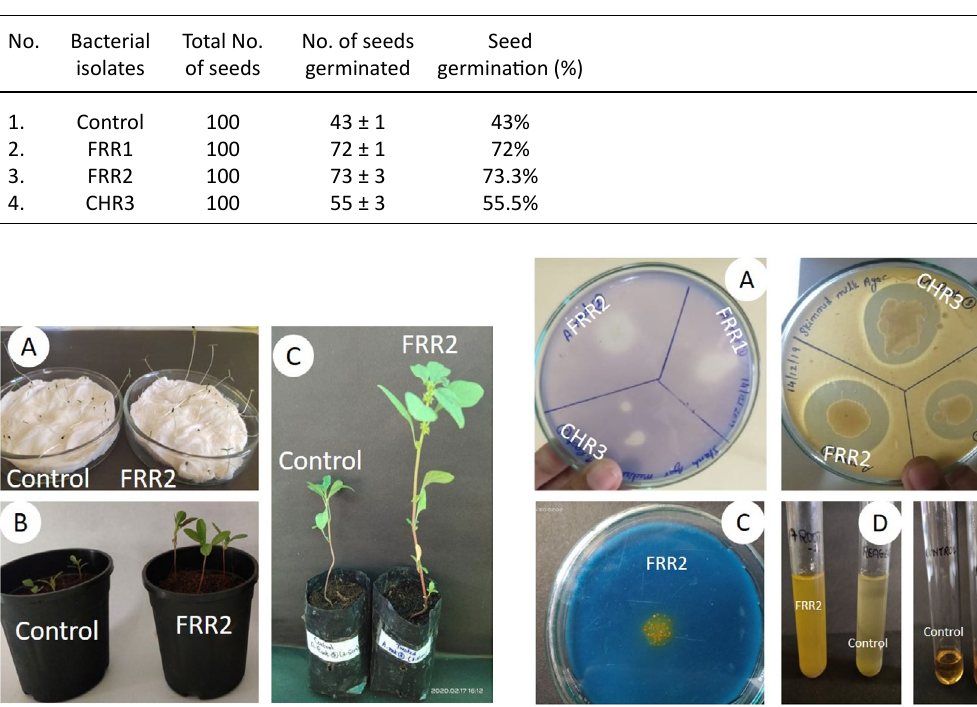
Fig. 1. Effect of endophyte (FRR2) on A. campestris L seed germination (A) in tissue paper placed on petri plates, seedling (B) growth at pots, and plant growth (C) in plastic bags.